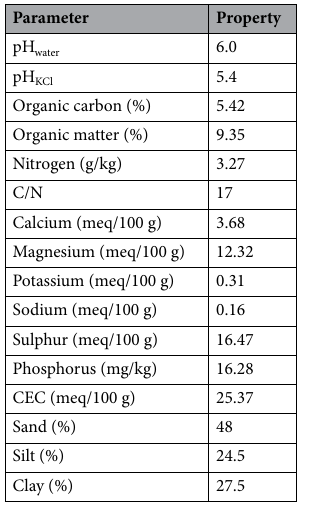
Table 1. Physicochemical properties of the soil.